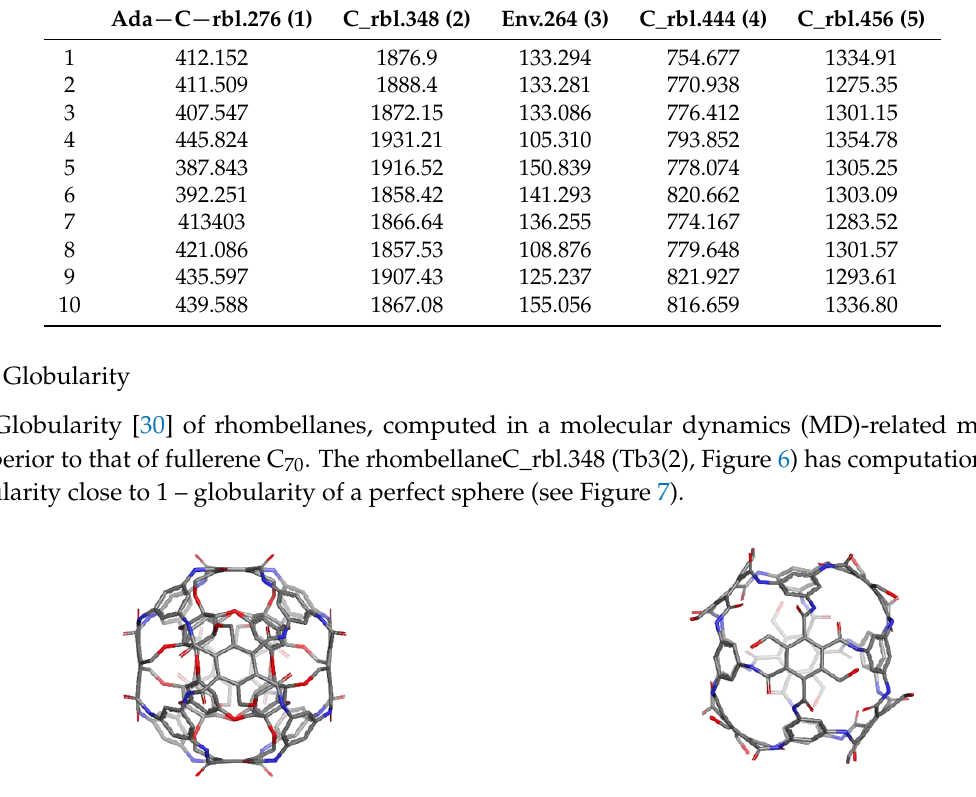
Table 3. MM conformational energies for the molecular structures Tb3( 1 to 5 ) (kcal/mol). Ada−C−rbl.276 (1)